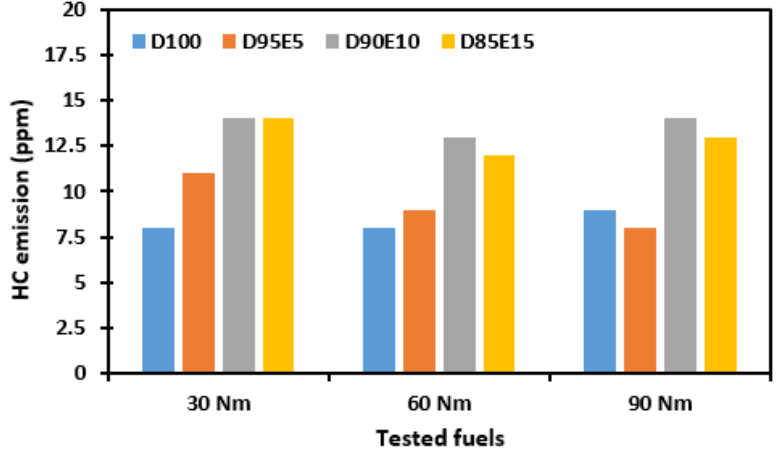
Figure 8. HC emissions for all test fuels according to various engine loads.